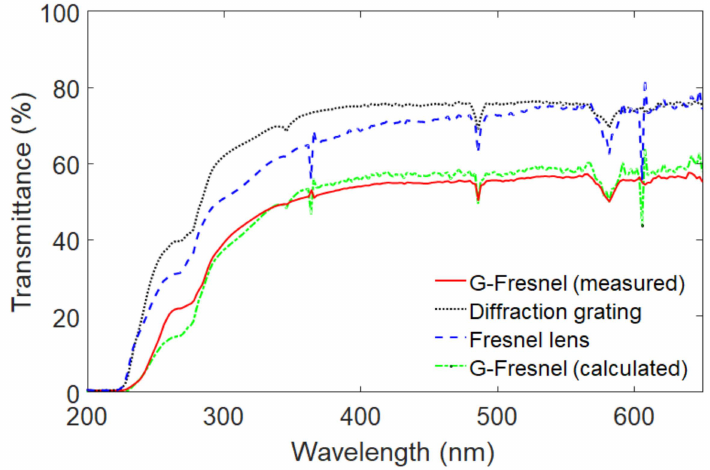
Figure 4. Transmittance curves of the G-Fresnel optical device, a PDMS Fresnel lens, and a PDMS di ff raction